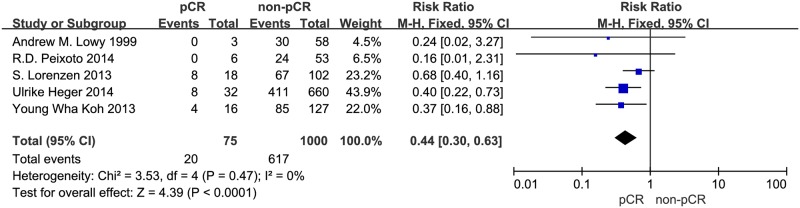
Forest plot of pooled relative risk for five-year OS from eligible studies.The area of each square represents the weighting, and the positions of each square demonstrate the risk ratio point estimate. Horizontal lines represent 95% confidence interval (CI). M-H = Mantel-Haenszel. Events = patients died from any cause within five years.